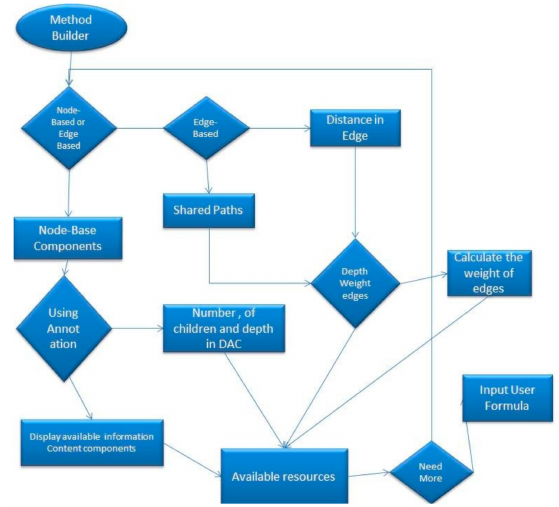
Figure 1. Selection of algorithm